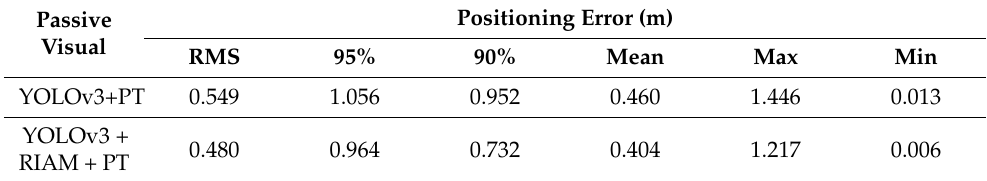
Figure 14. CDF of the whole positioning error. Table 3. Various statistical results.